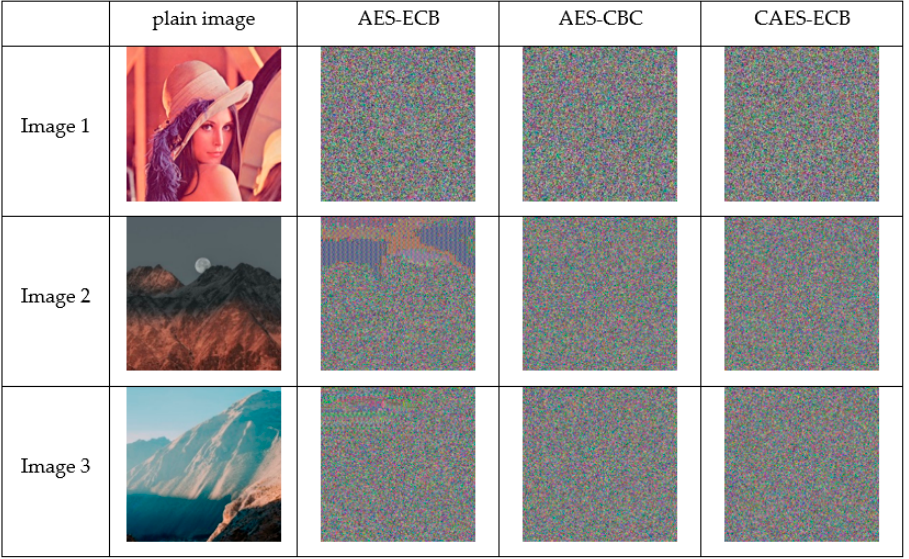
Figure 10. Visual effect of encrypted images.